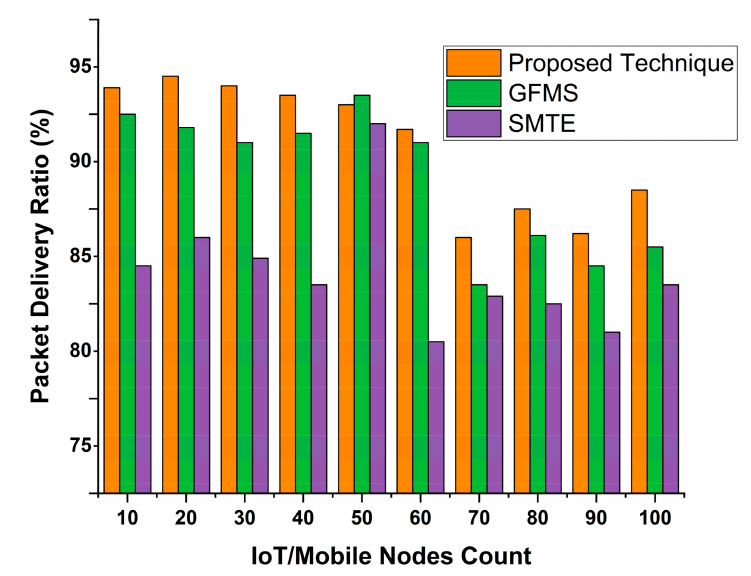
Figure 11. Packet delivery